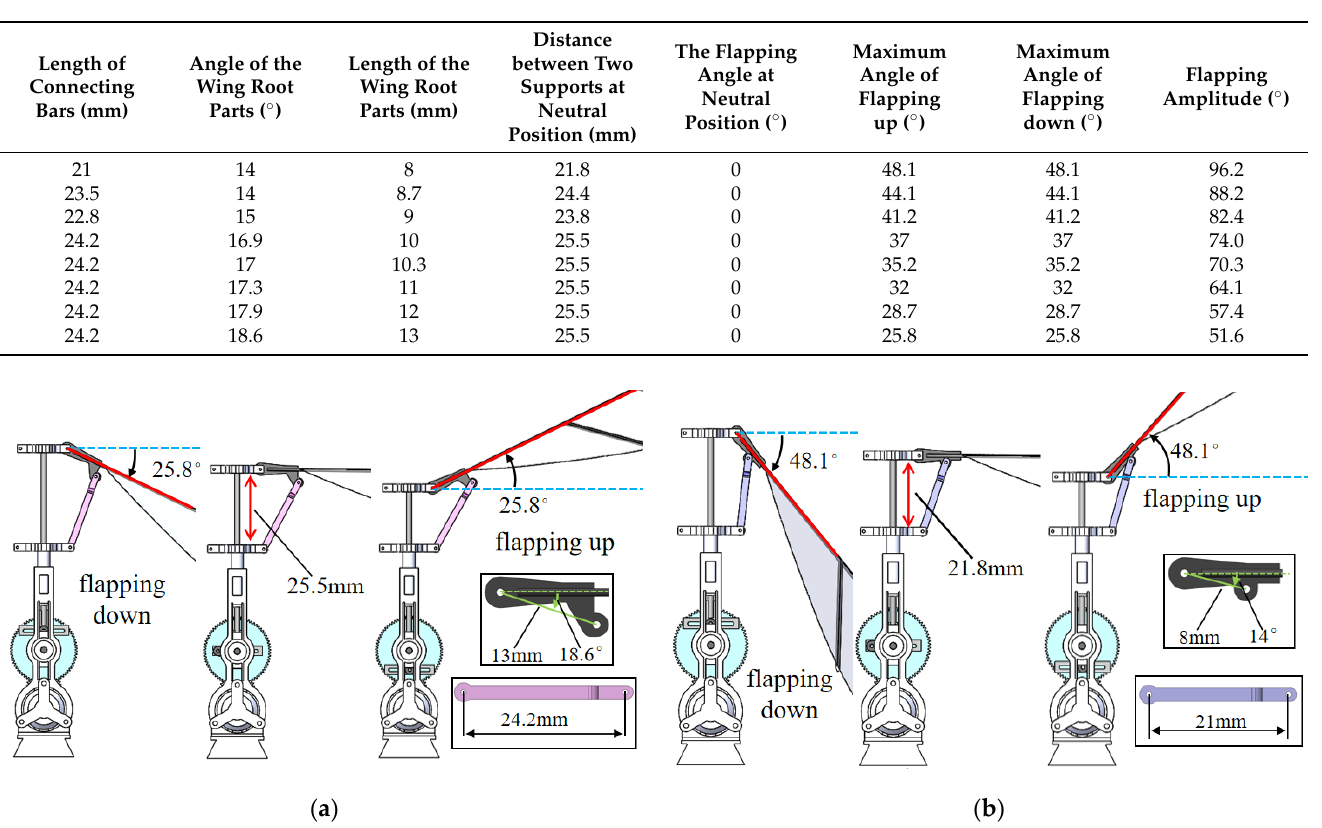
Table 5. The parameters of FWR with different flapping amplitudes.